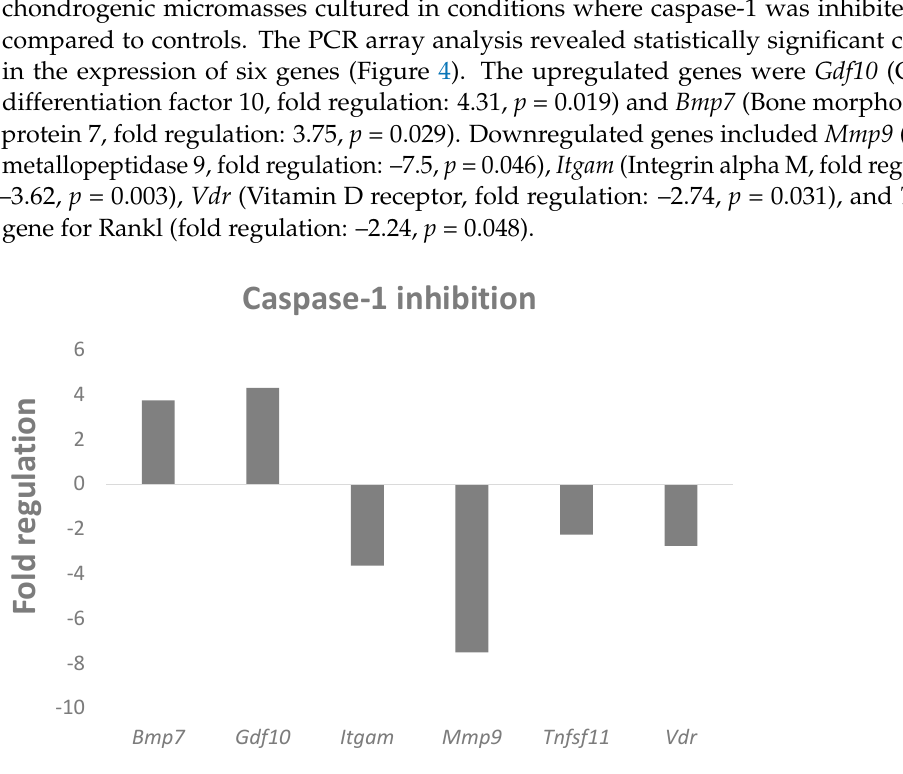
Figure 4. PCR array analysis of osteogenic gene expression in micromass cultures after 6 days of caspase-1 inhibition compared to control. Only osteogenic genes with statistically significant ( p ≤ 0.05) changes in gene expression are showed.